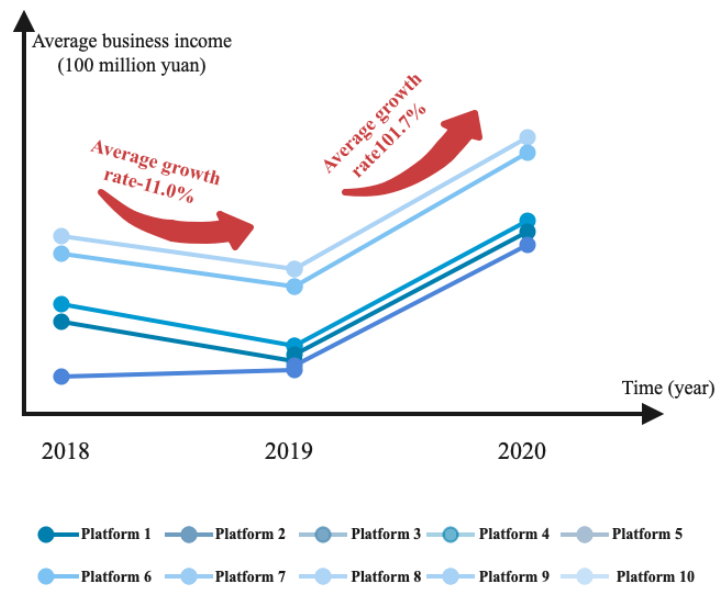
Figure 10. Average business revenue of the top ten platforms from 2018 to 2020.